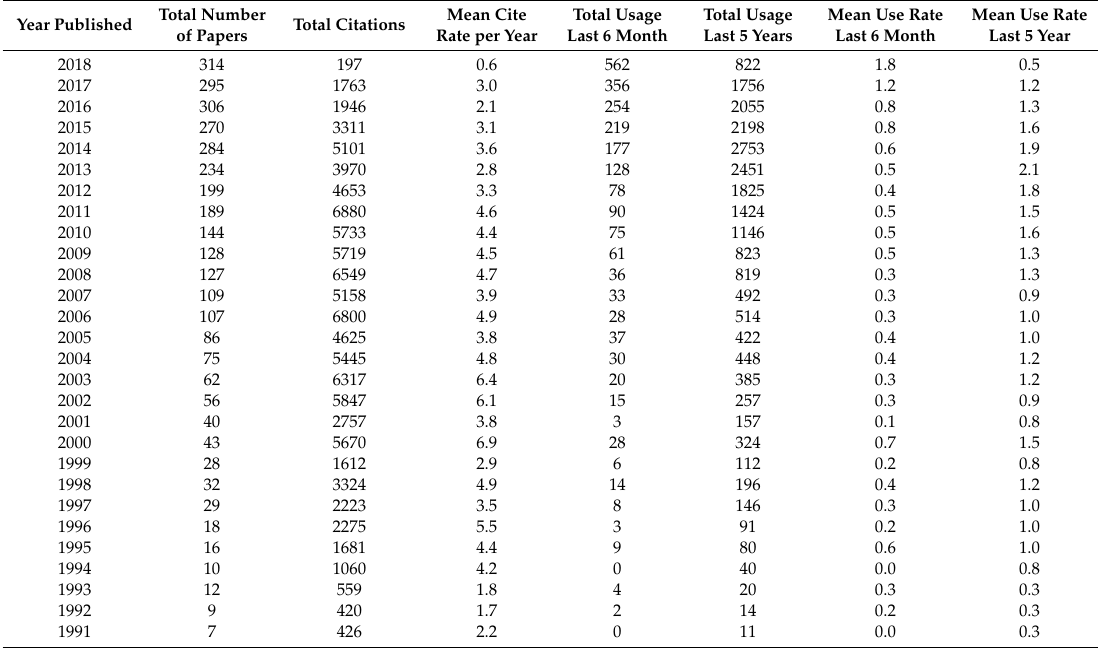
Table 2. General characteristics of